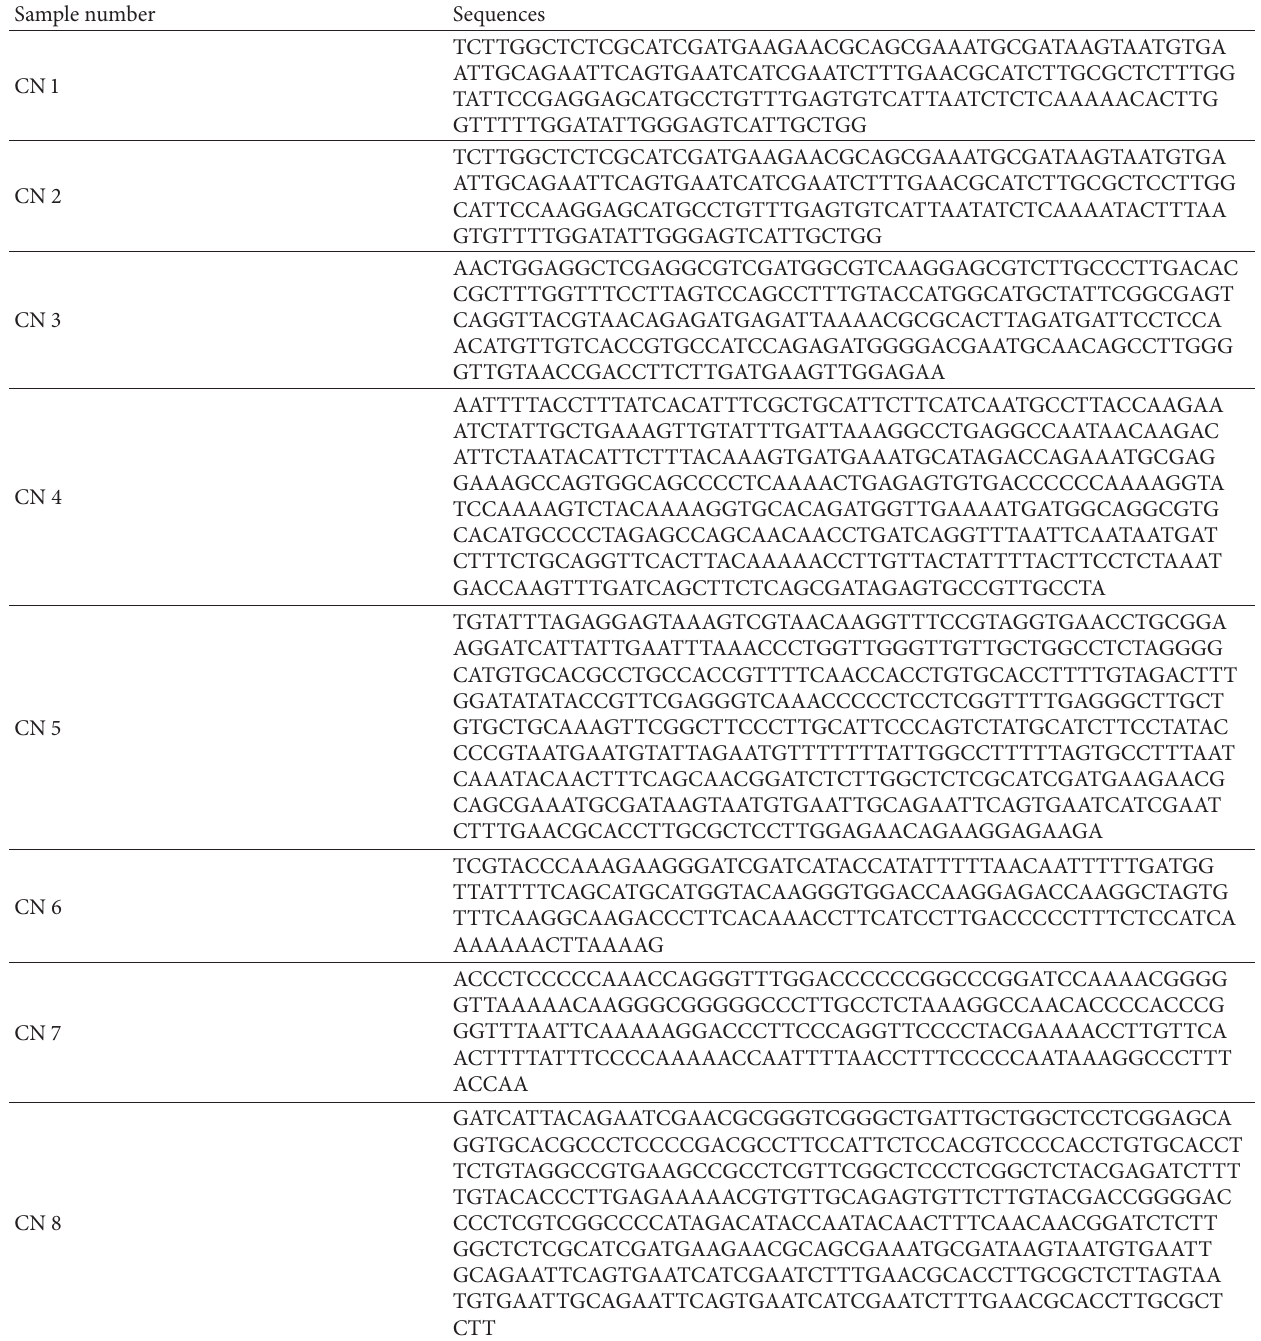
Table 2: Partial nucleotide sequences of the field isolated mushroom